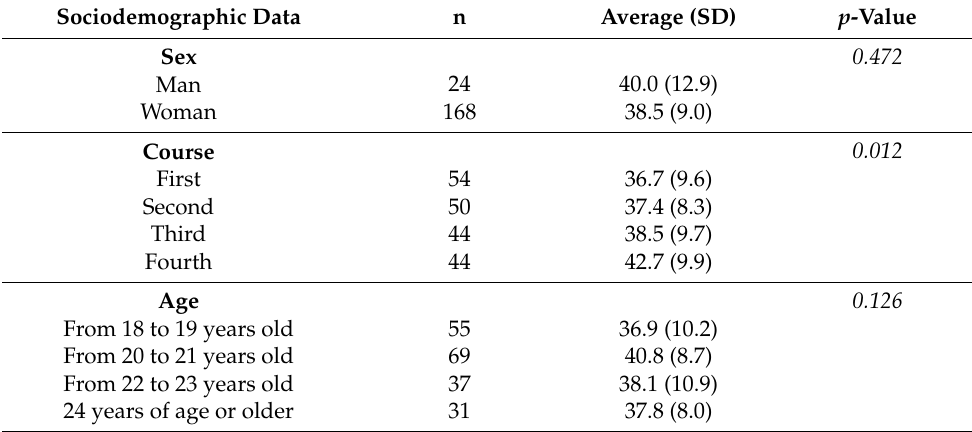
Table 2. Analysis of the occupational balance: OBQ-E according to sociodemographic data.